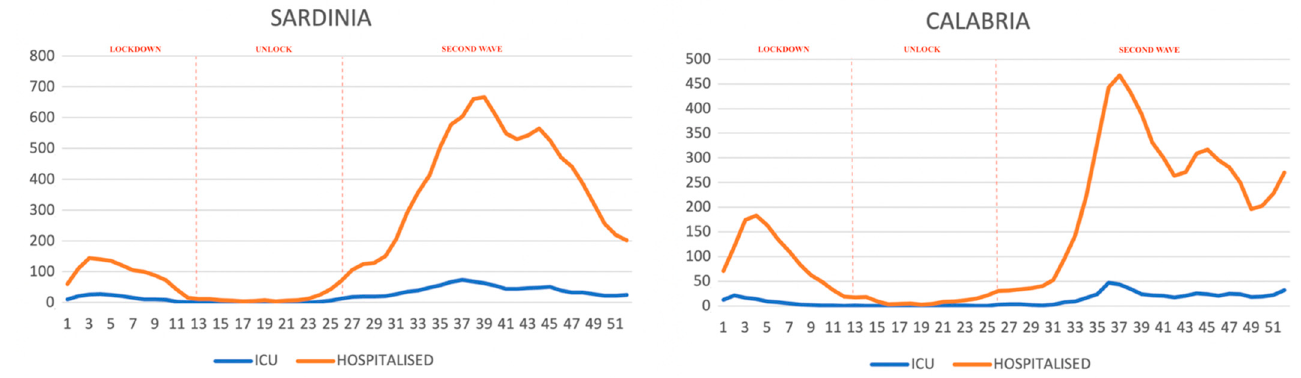
Figure 2. The average weekly COVID-19 hospitalisations and intensive care unit (ICU) admissions over time in Sardinia and Calabria during the first year of pandemic (52 weeks). The dotted orange line divided the period studied into three phases: lockdown, unlock, and second wave.